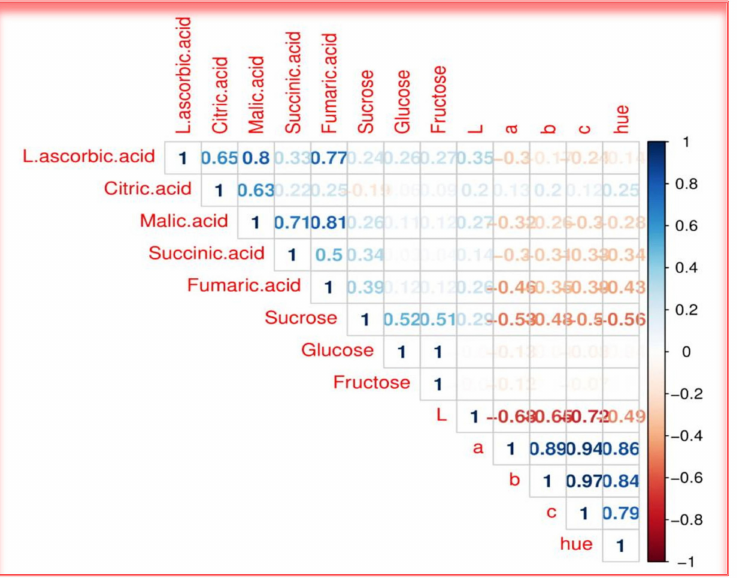
Figure 1. Correlation graphic for organic acids, sugars, and color parameters of strawberry fruits as affected by different organic or chemical fertilizer